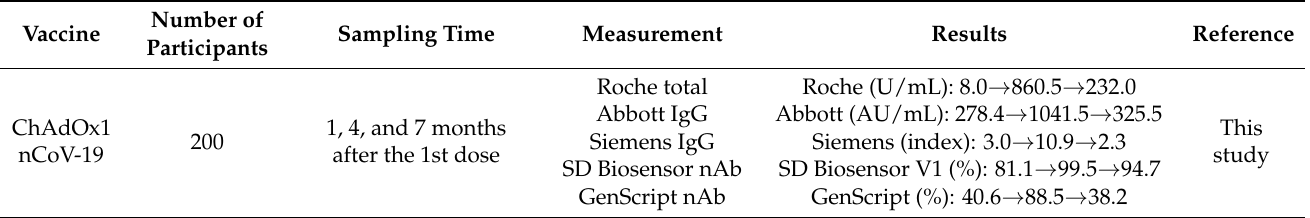
Table 5. Summary of studies for the longetivity of the SARS-CoV-2 antibodies after ChAdOx1 nCoV-19 and mRNA